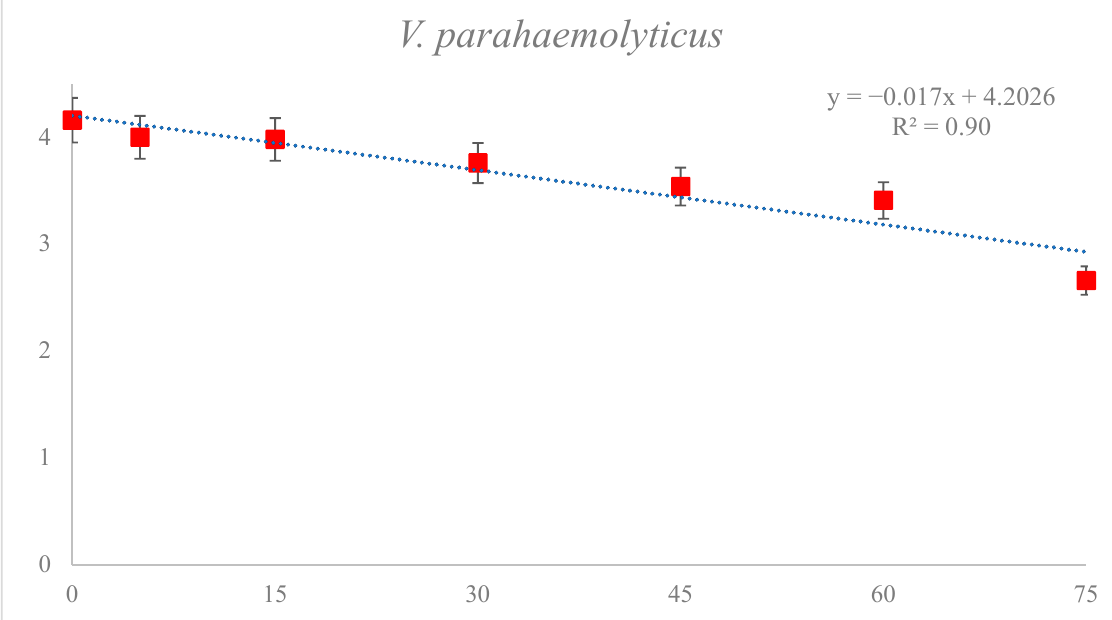
Table 4. Effect of FE-DBD plasma treatment on D-values of HNoV GII.4, HNoV GII.4 with PMA and V. parahaemolyticus , and reduction by first-order kinetics model in the sea squirt.